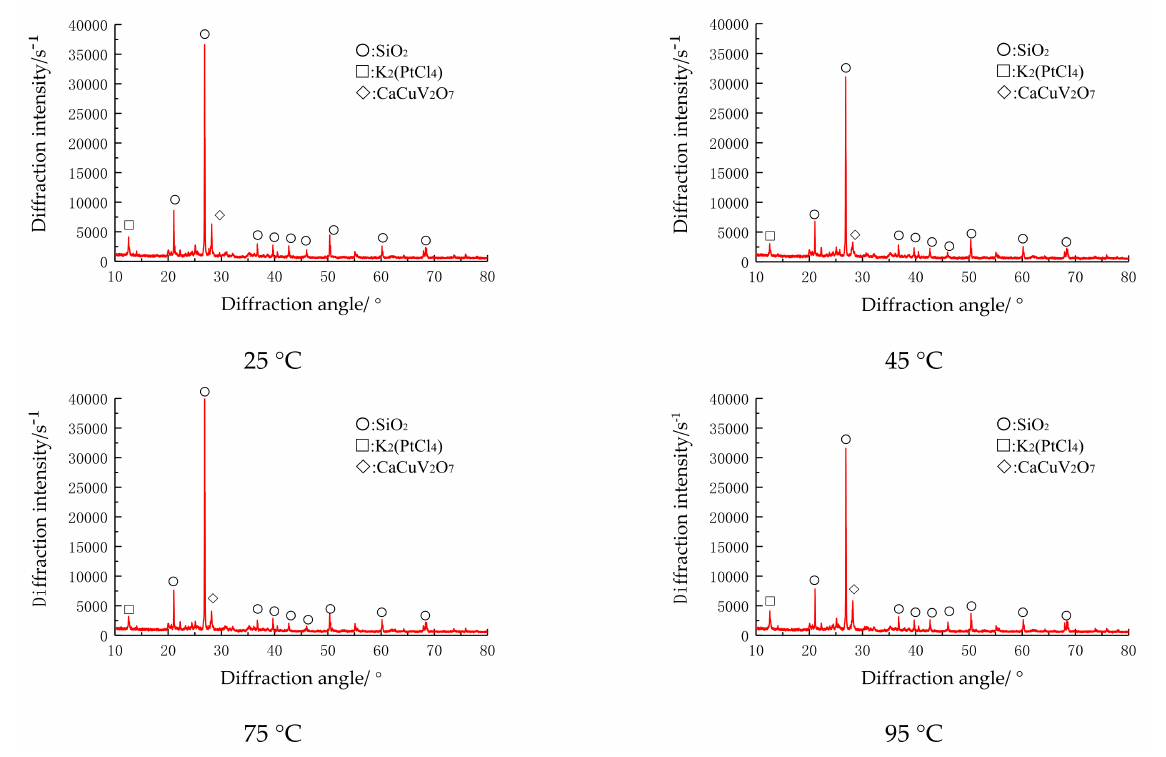
Figure 13. XRD patterns of sandstone specimens treated with different water bath temperatures.